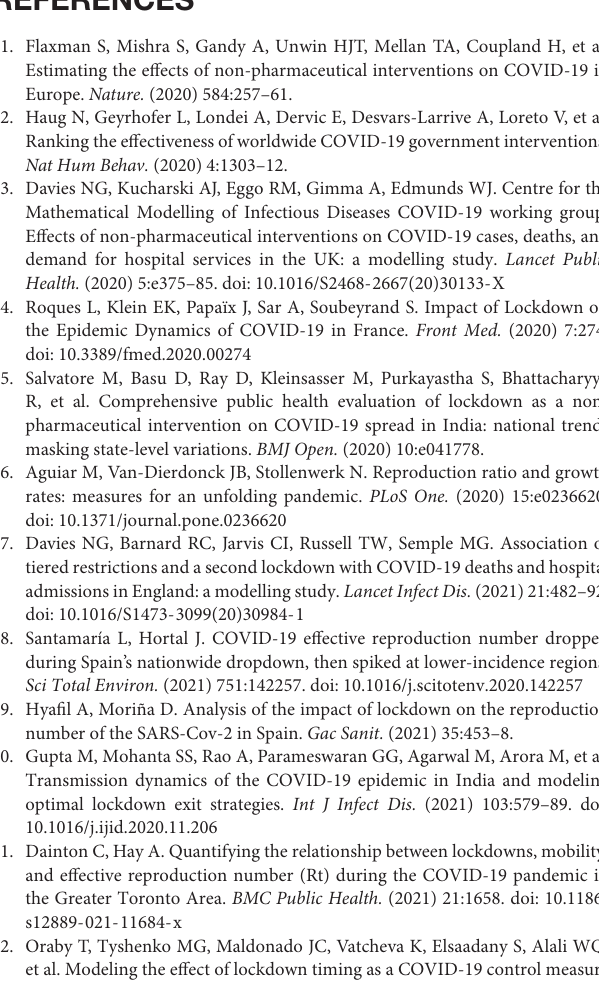
Supplementary Figure 1 | Relationship between state of emergency (SoE) categories and reduction in the effective reproduction number ( R t ) during an SoE compared with the 7 days before intervention (baseline period). This figure shows the relationship between the reduction in R t during the 7 days prior to the intervention and during the 7 days after the intervention and presence of each SoE intervention. The only SoE categories for which there were differences in adoption among prefectures were (A) school-related measures, (B) expansion of the intervention scope (SoE originally implemented in only part of a given prefecture expanded to additional areas), and (C) requests (from the prefecture) for no out-of-prefecture travel. We calculated p-values using the Wilcoxon signed-rank test. The left-hand panel in each figure shows the absolute reduction in R t and the right-hand panel shows the relative reduction in R t . Supplementary Figure 2 | Relationship between prefectural COVID-19 epidemic stage at the start of a state of emergency (SoE) and reduction in the effective reproduction number ( R t ) during the SoE compared with the 7 days before intervention (baseline period). This figure shows the relationship between the reduction in R t during the 7 days prior to the intervention and during the 7 days after the intervention and the epidemic stage at the time of the intervention. The horizontal axis is the “stage” of the COVID-19 epidemic according to definitions of the Japanese government. (A,B) Hospital-bed occupancy is defined as stage 3 when 20% of COVID-19 beds are occupied and stage 4 when 50% of beds are occupied. (C) The prevalence of active cases is defined as the number of patients